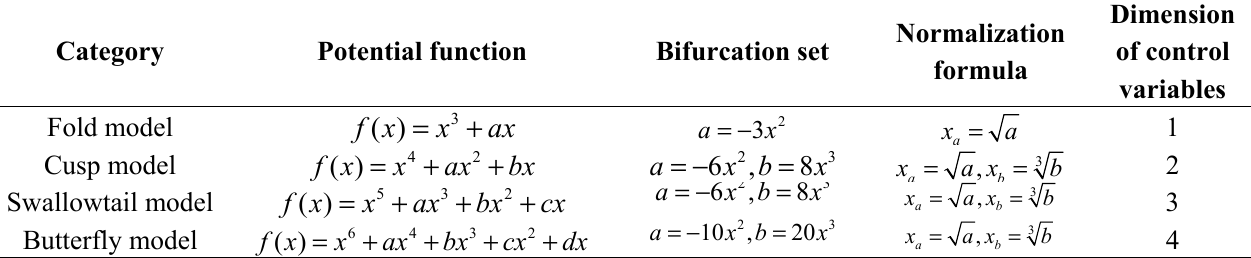
Table 2. Summary of catastrophe